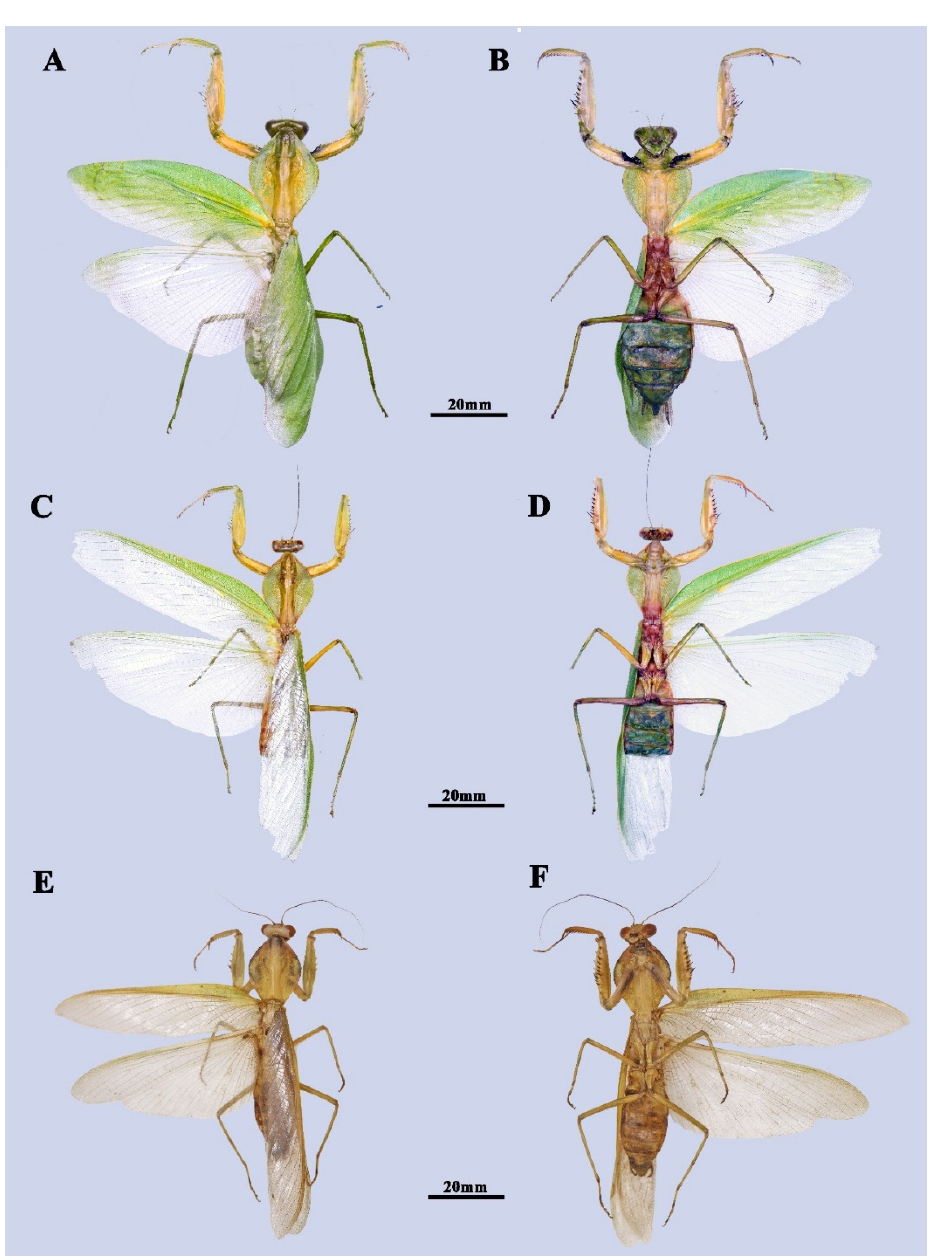
Figure 4. Rhombodera hyalina sp. nov. , paratype. ( A , B ) Paratype2, female. ( C , D ) Paratype3, male. ( E , F ) Paratype4, male.